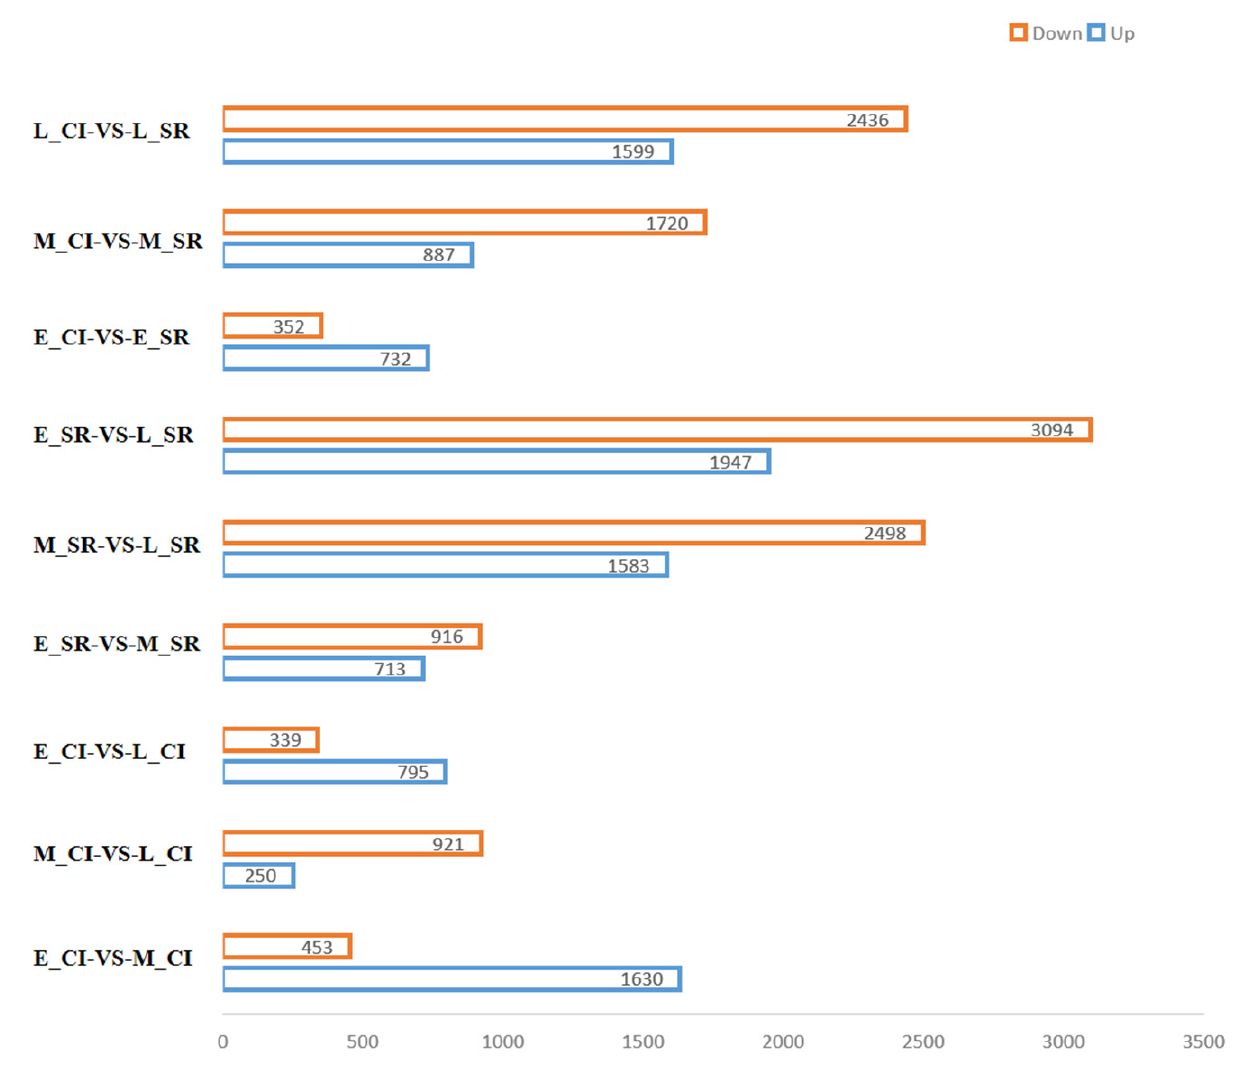
Figure 2. DEGs identified from different comparisons.